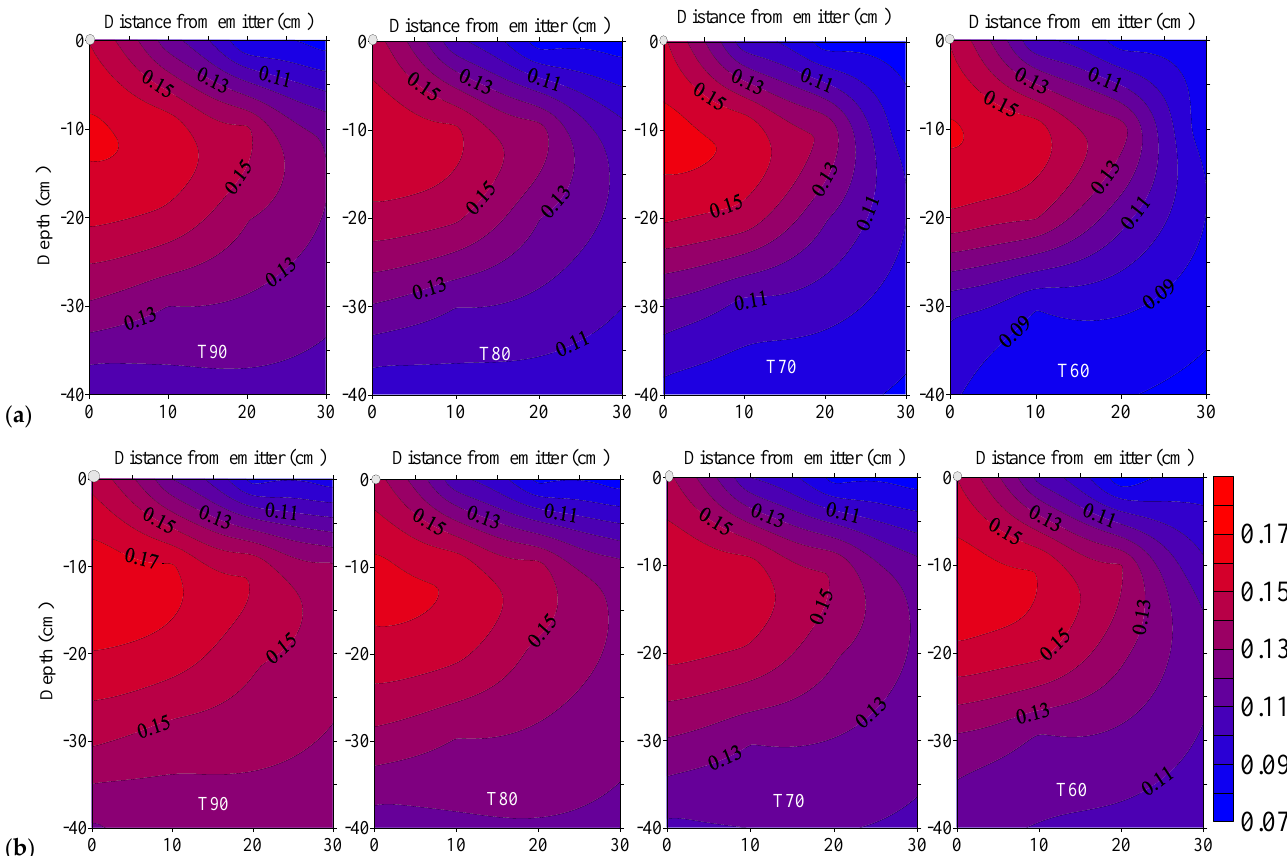
Figure 5. Average SWC (cm 3 cm − 3 ) 24 h after the first, middle, and last irrigation events for the four irrigation treatments, ( a ) constant average root depth, and ( b ) considered root growth during the growing season.